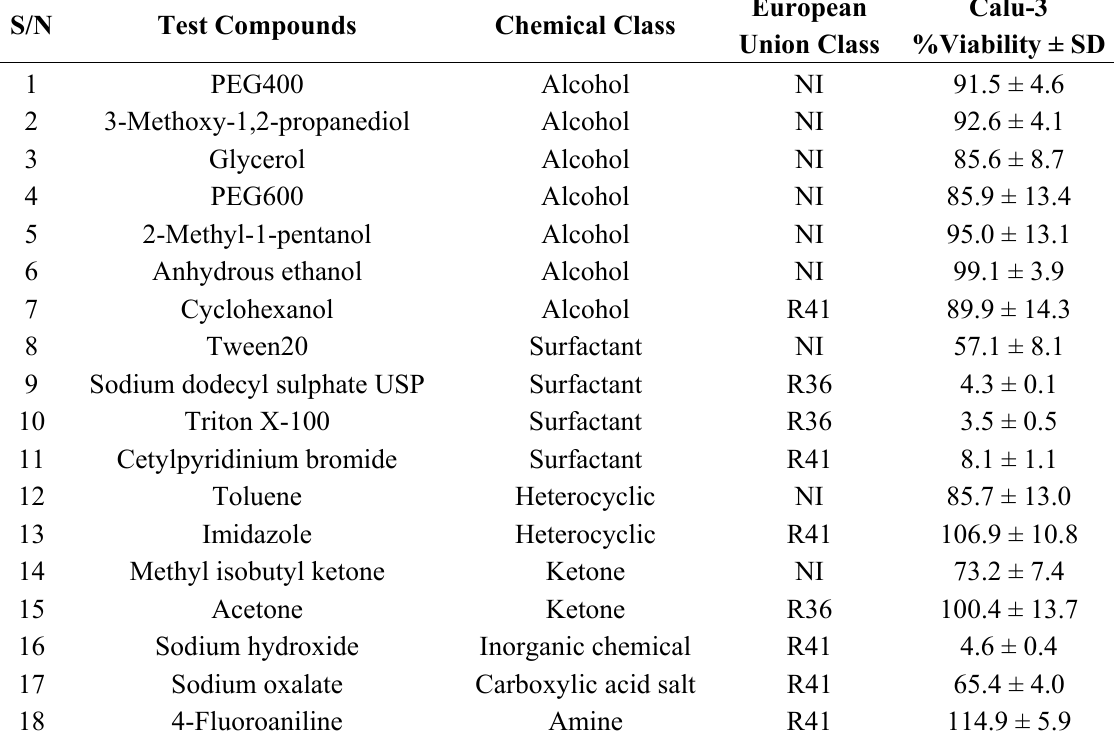
Table 2. Effect of test compounds on Calu-3 cells viability after incubation with 0.2% test solutions for 60